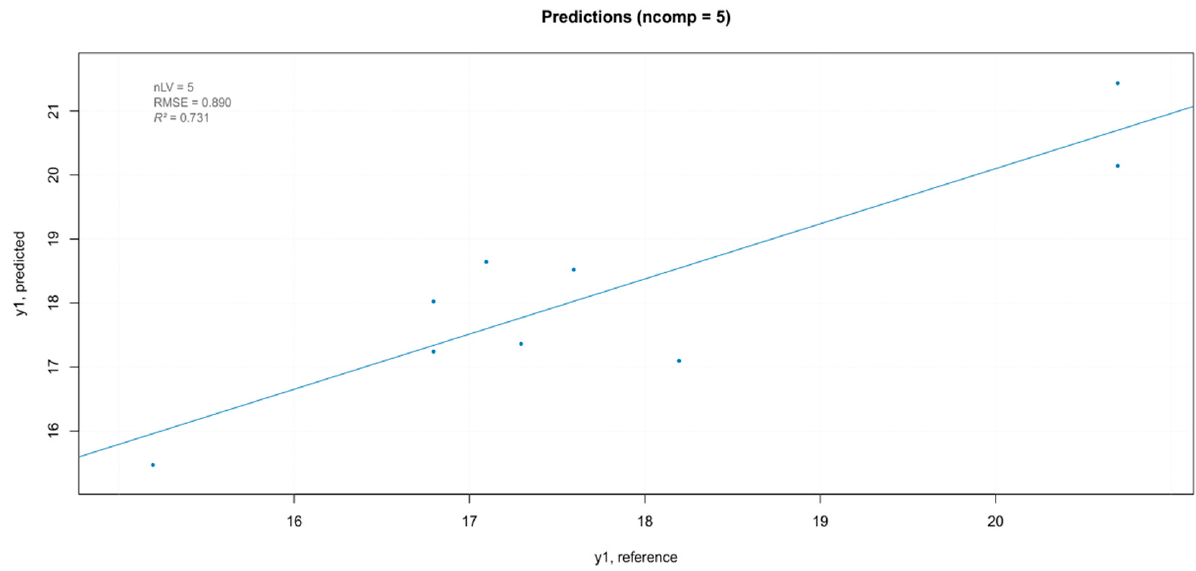
Figure 18. Results of the external validation for the TSS model.